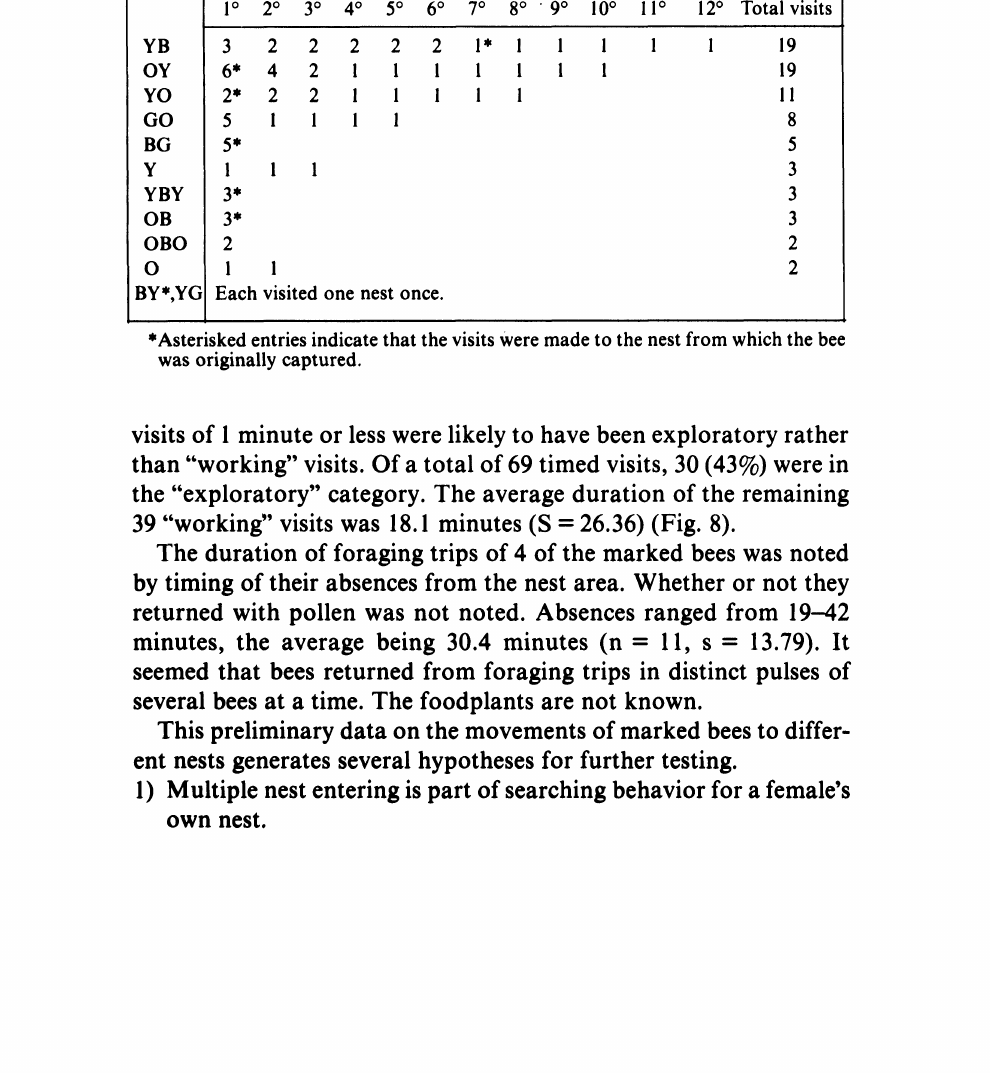
Table 2. Number of visits made by marked bees to particular nests. Nest